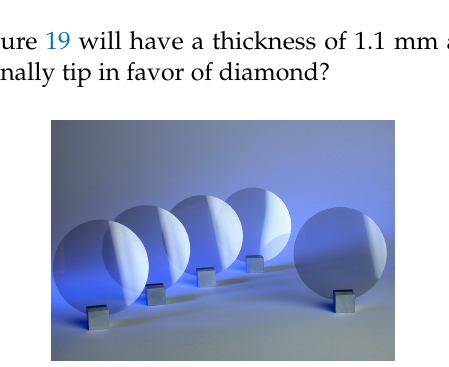
Figure 19. Sample of diamond windows produced by CVD. Reprinted with permission from Ref. [116]. Credit c (cid:13) Diamond Materials,